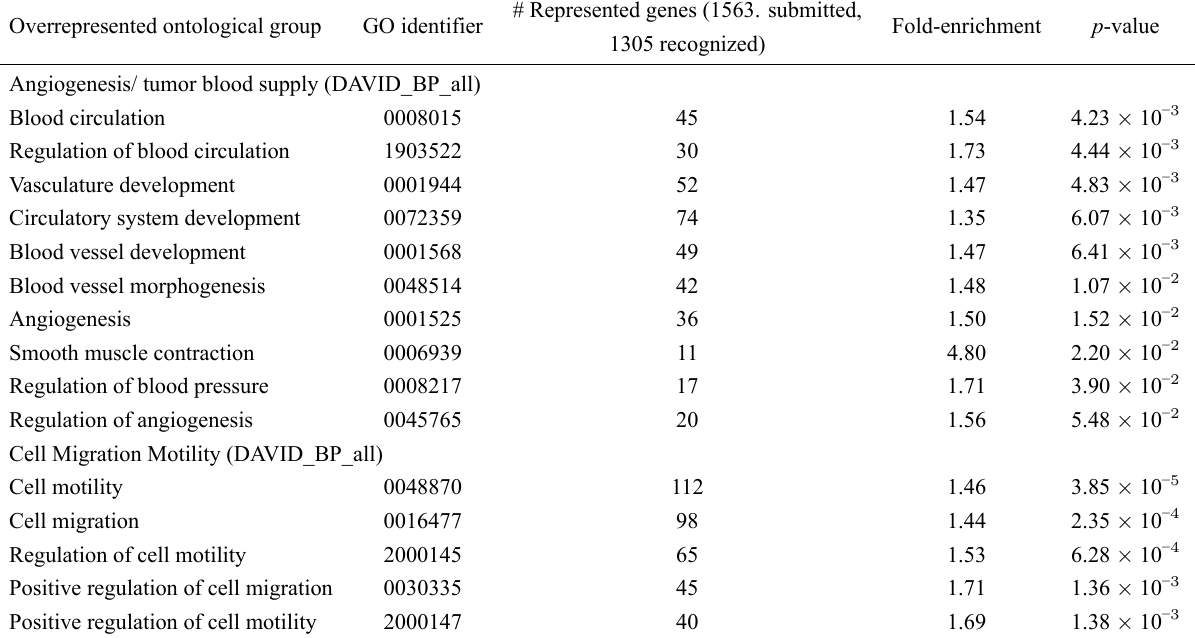
Table 2A. Gene ontology analysis of differentially expressed genes resulting from PROL1 knockout in LNCaP cells: angiogenesis/tumor blood supply/cell migration